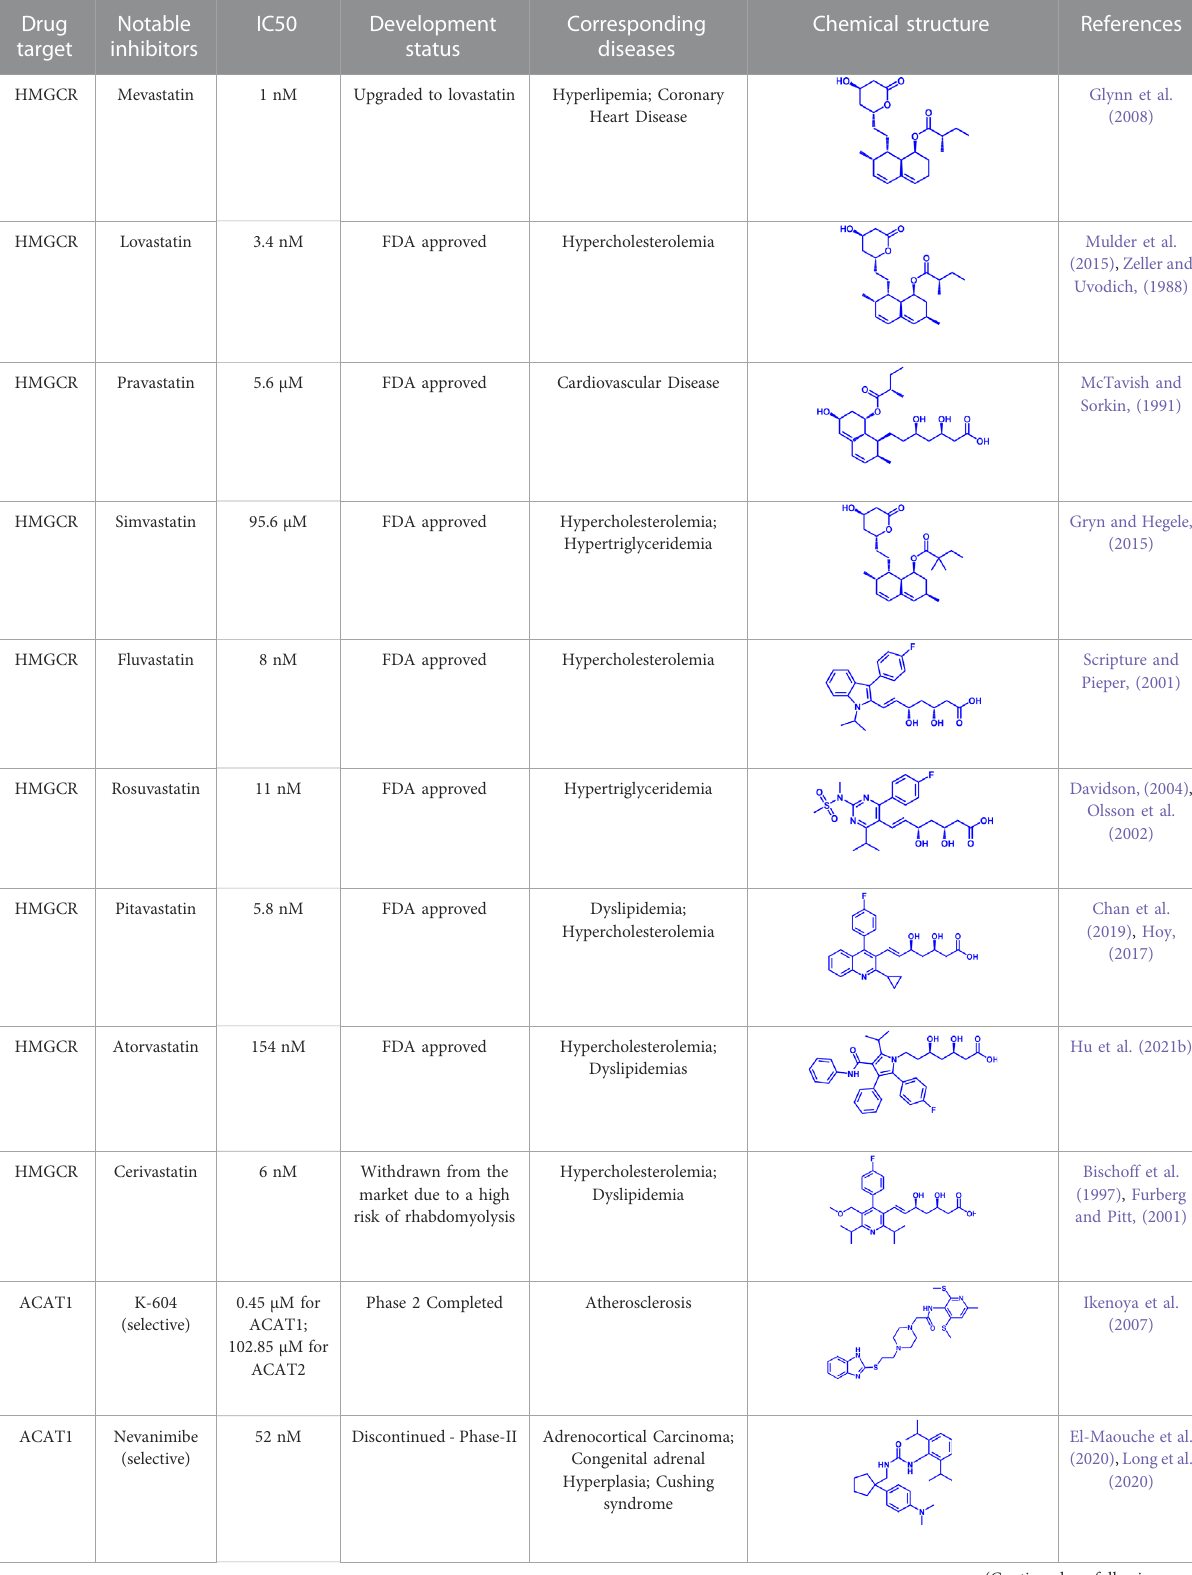
TABLE 3 Potential pharmacological targets and related inhibitors targeting cholesterol